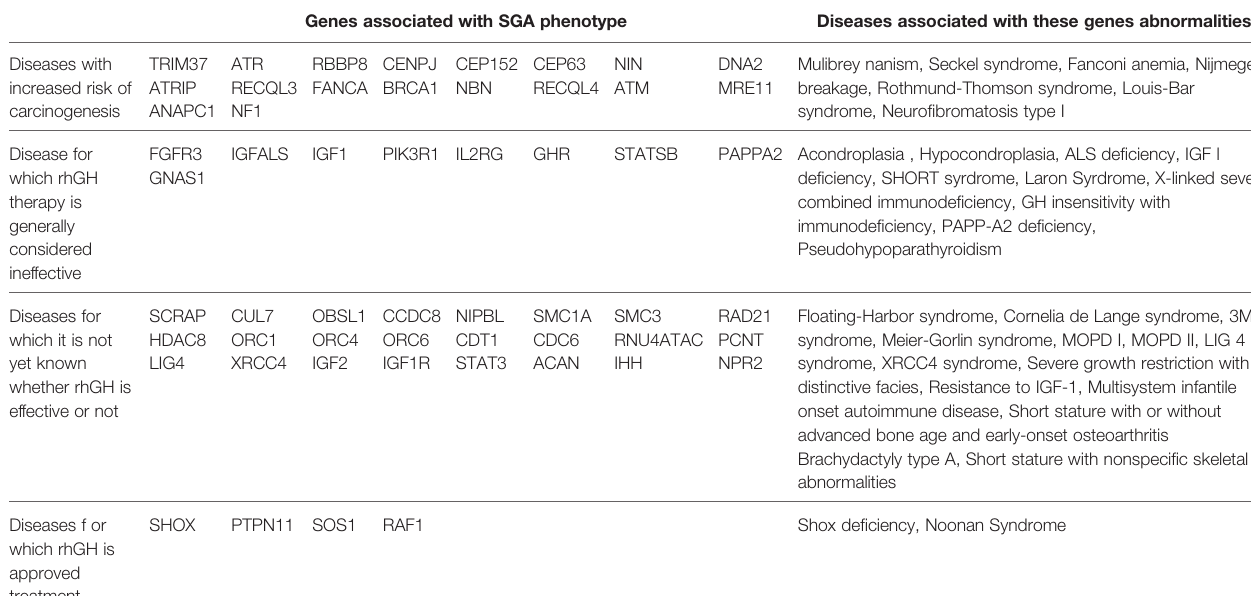
TABLE 1 | Some genes responsible for pre-natal short stature and included in a genetic screening panel. Genes associated with SGA phenotype Diseases associated with these genes